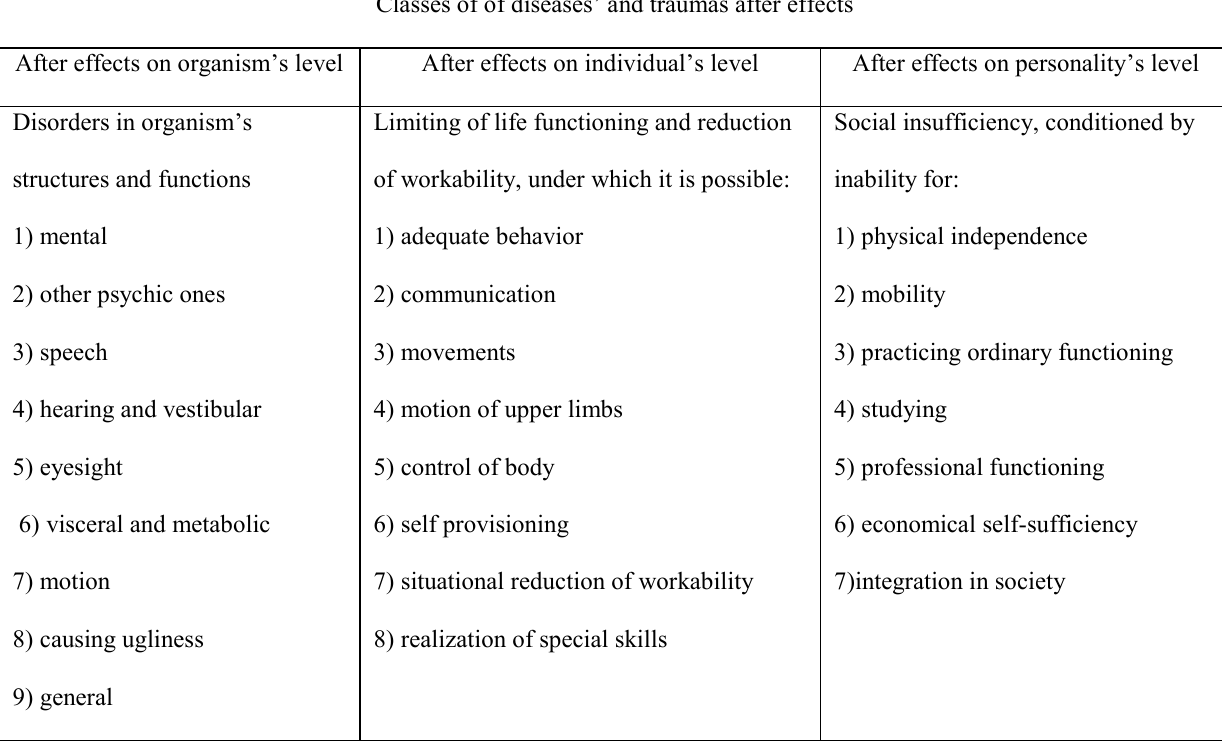
International nomenclature of disorders, restrictions of life functioning and social insufficiency